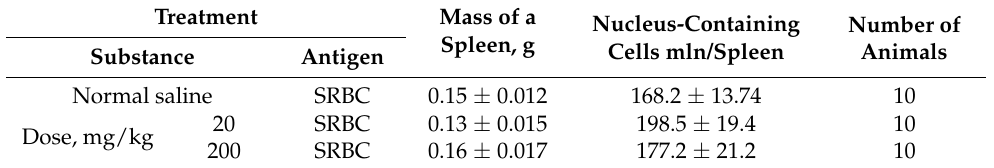
Table 4. Indicators of body weight, spleen, the number of nucleus-containing cells in immunized mice.